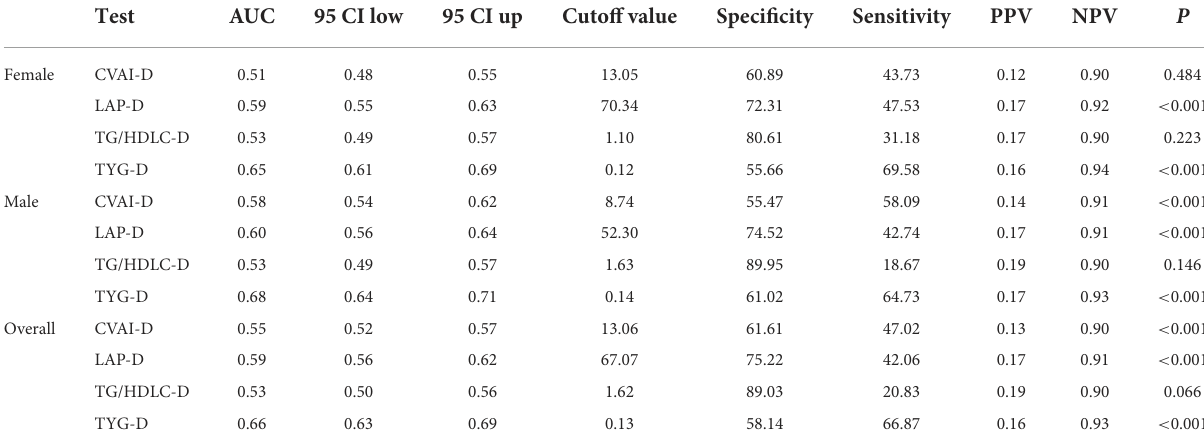
TABLE 3 Comparison of predictive accuracy and cut-off values of four surrogate indexes for T2DM by